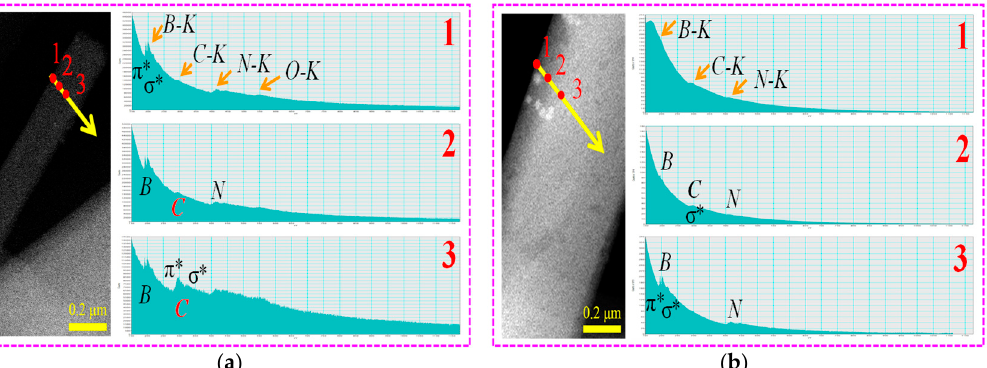
Figure 9. EELS mappings of ( a ) p-BCN-1 and ( b ) p-BCN-2. The Arabic digits on the yellow arrow represent the location of the tested sample, and the Arabic digits on the spectrograms represent the EELS mappings determined at the corresponding location of samples.